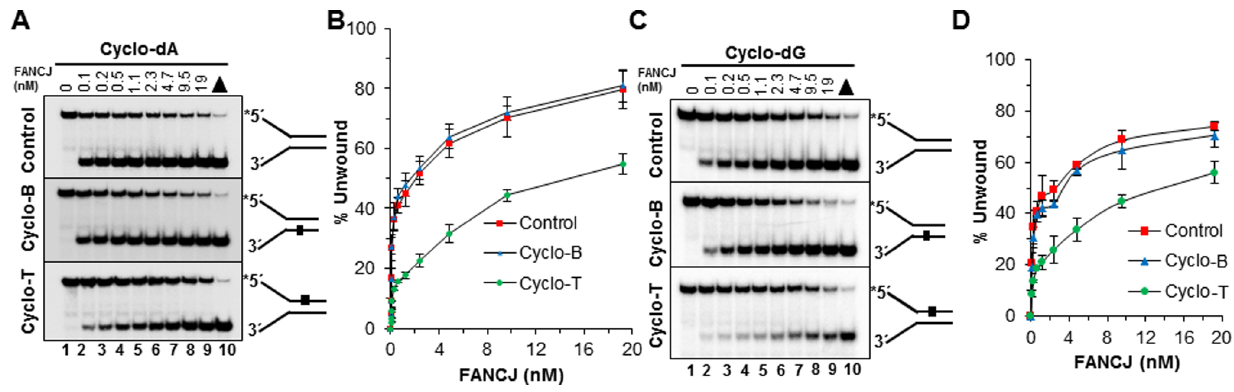
Figure 6. Effect of a site- and strand-specific cyclopurine lesion on FANCJ helicase activity. Helicase reactions were carried out by incubating the appropriate FANCJ concentrations with 0.5 nM forked duplex DNA that contained a cyclopurine lesion in the top strand (translocating-Cyclo T), bottom strand (nontranslocating-Cyclo B), or neither strand (Control) at 30 u C for 15 min under standard helicase assay conditions described in the Materials and Methods. E, FANCJ unwinding of undamaged and cyclo dA damaged DNA substrates. Lane 1, no enzyme control; lanes 2–9 indicated concentrations of FANCJ; lane 10, heat- denatured DNA substrate control. F, Quantification of FANCJ helicase activity on cdA substrates with error bars. G, FANCJ unwinding of undamaged and cyclo dG damaged DNA substrates. lane 1, no enzyme control; lanes 2–9, indicated concentrations of FANCJ; lane 10, heat- denatured DNA substrate control. H, Quantification of FANCJ helicase activity on cdG substrates with error bars.